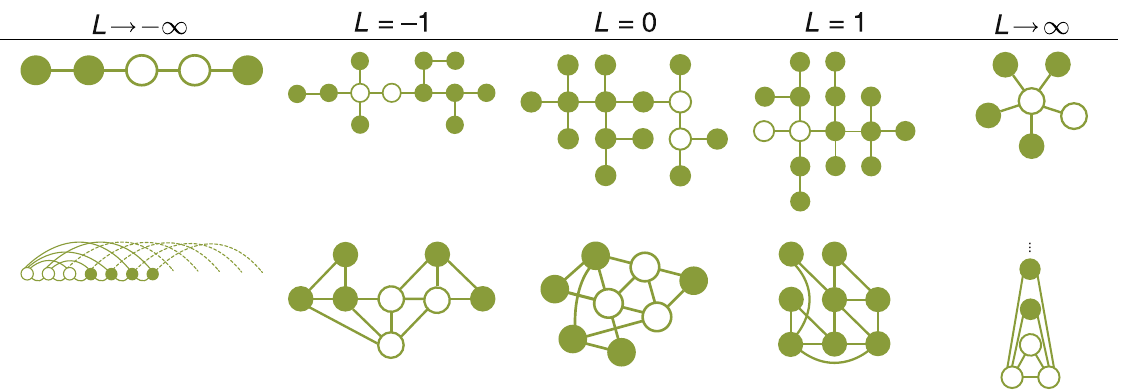
Fig 1. Social networks that arise when newcomers use popularity to guide their selection of friends. Starting with Euler in 1736, the study of network topology has been couched in terms of graph theory, which represents individuals as nodes (drawn here as green circles) and a connection between two individuals as an edge between two nodes (green lines). Together, the nodes and edges define a graph. The arrangement of the nodes on the page is nonessential; what matters is who links to whom. The networks shown here were constructed through a process in which the newcomer samples m times (without replacement) from the distribution defined by Eq 1 and links up with whomever is selected [1]. Each network began as a complete (i.e., fully- connected) graph with m +1 nodes (open circles) and grew with the arrival of newcomers (filled circles).